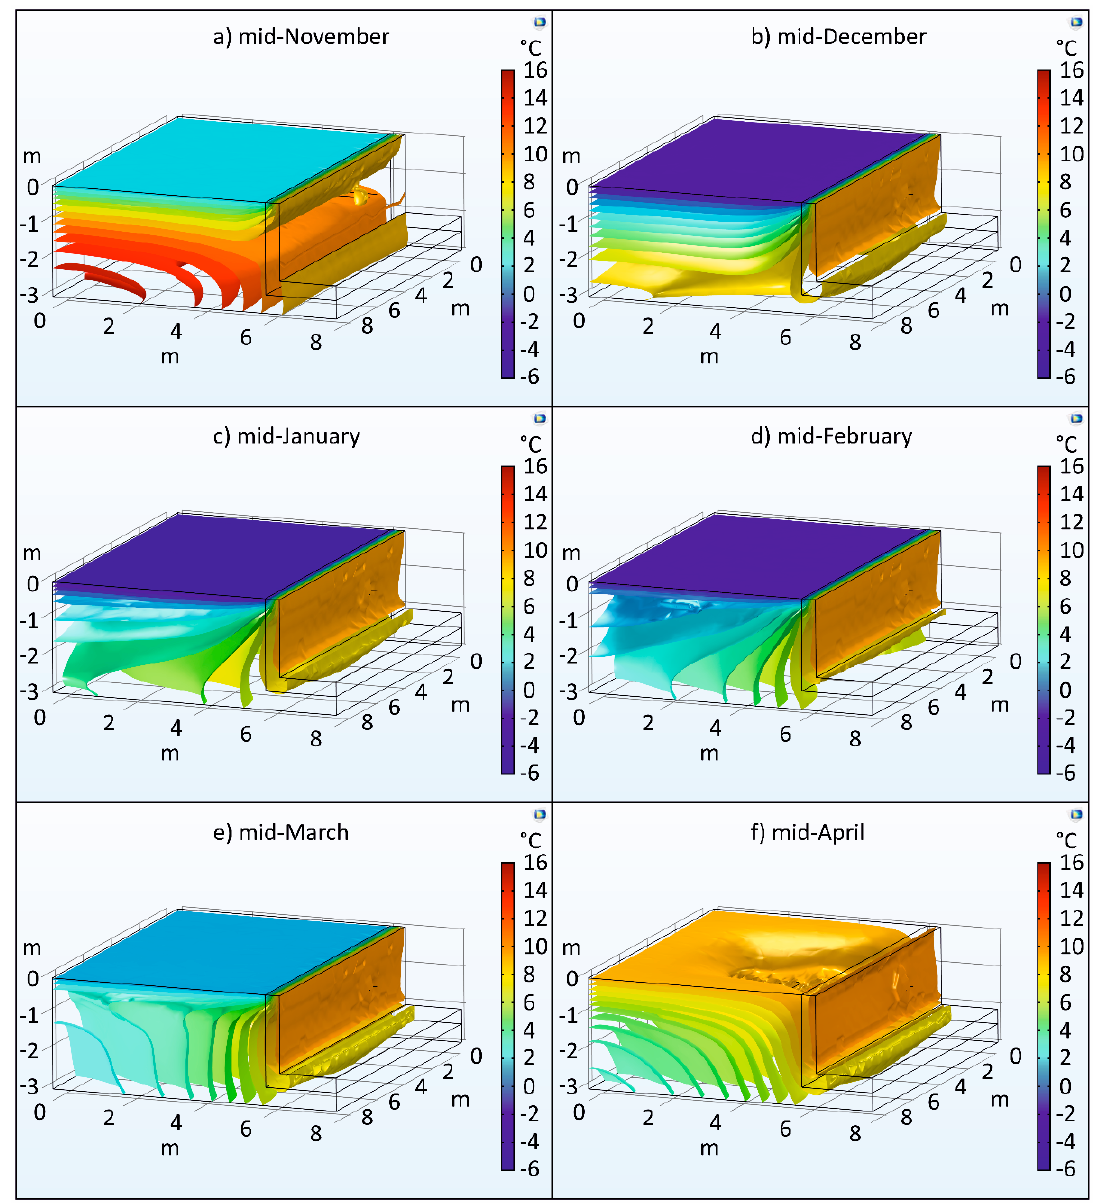
Figure 4. The tri-dimensional temperature isosurfaces for the simulation case 1—HGHE with no auxiliary heat sources: ( a ) mid-November; ( b ) mid-December; ( c ) mid-January; ( d ) mid-February; ( e ) mid-March; ( f ) mid-April.